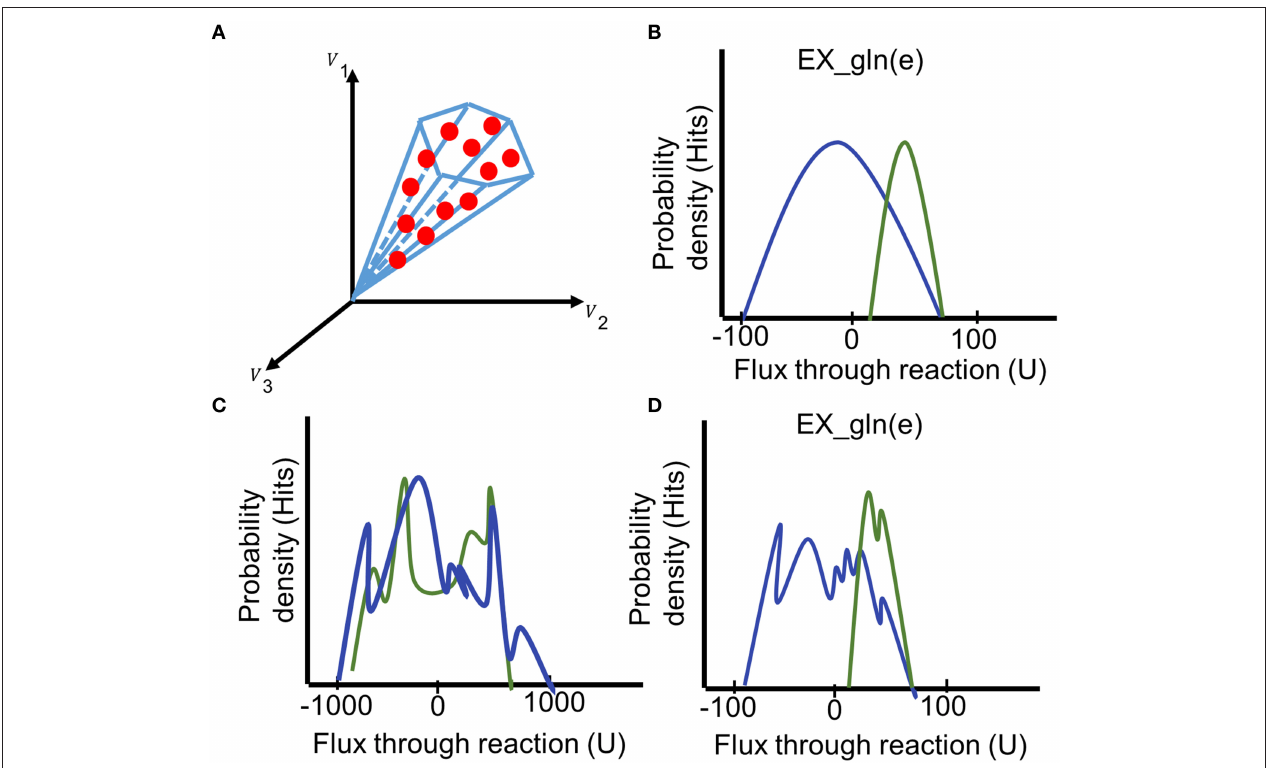
FIGURE 8 | Interpreting the results of the sampling analysis. (A) During the sampling analysis, a large set of sampling points is collected (red dots, each comprising a flux distribution). The fluxes collected from the sampling points can be illustrated as probability distribution for individual reactions. (B) Comparing the histograms of the probability flux distributions through the glutamine exchange reaction in two models (blue and green) reveals a shift of the feasible steady-state solution space for this reaction. (C) The irregular histogram is typical for an unbounded reaction (distribution ranges from − 1000 to 1000). (D) A premature flux distribution of the glutamine exchange reaction. Even though the final shape of the distributions can be guessed, additional sampling points need to be generated to get a unimodal distribution of the fluxes. Generation of additional points could shift the distribution. U = flux units.